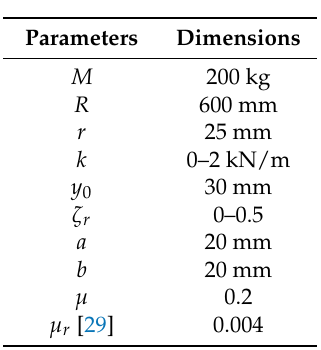
Table 1. Main dimensions and